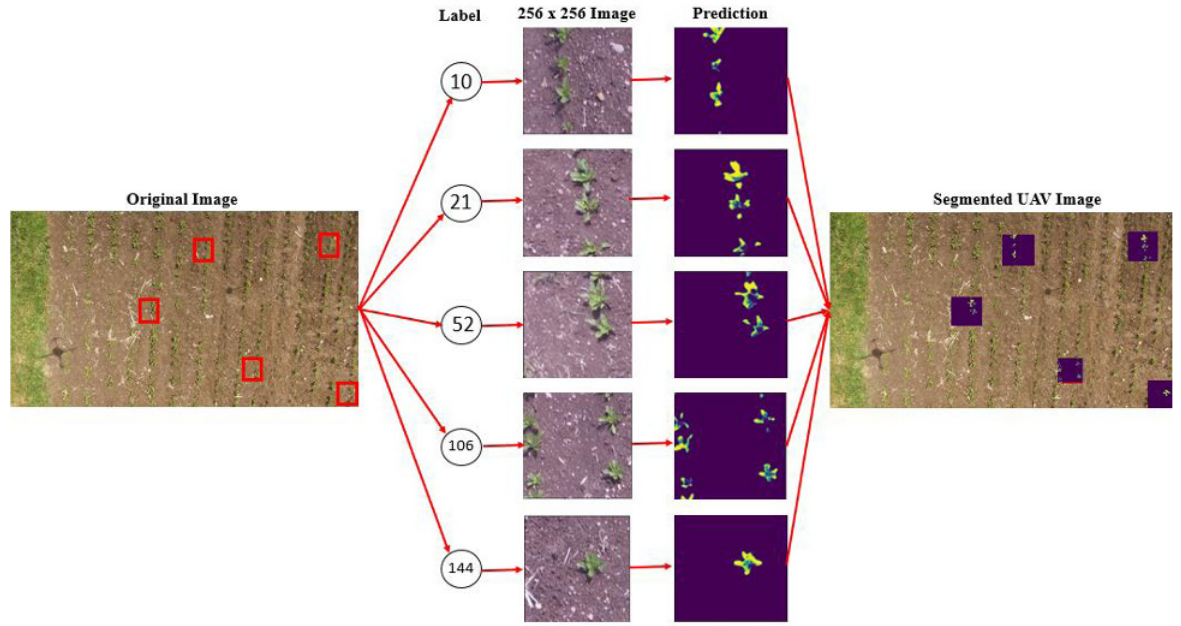
Fig. 7. Reconstruction